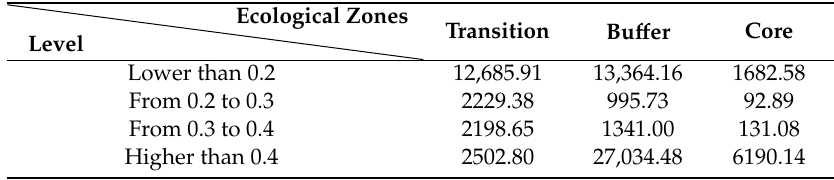
Table 3. The statistical area (ha) of NDVI categories through three ecological zones during the 2015–2019 period.